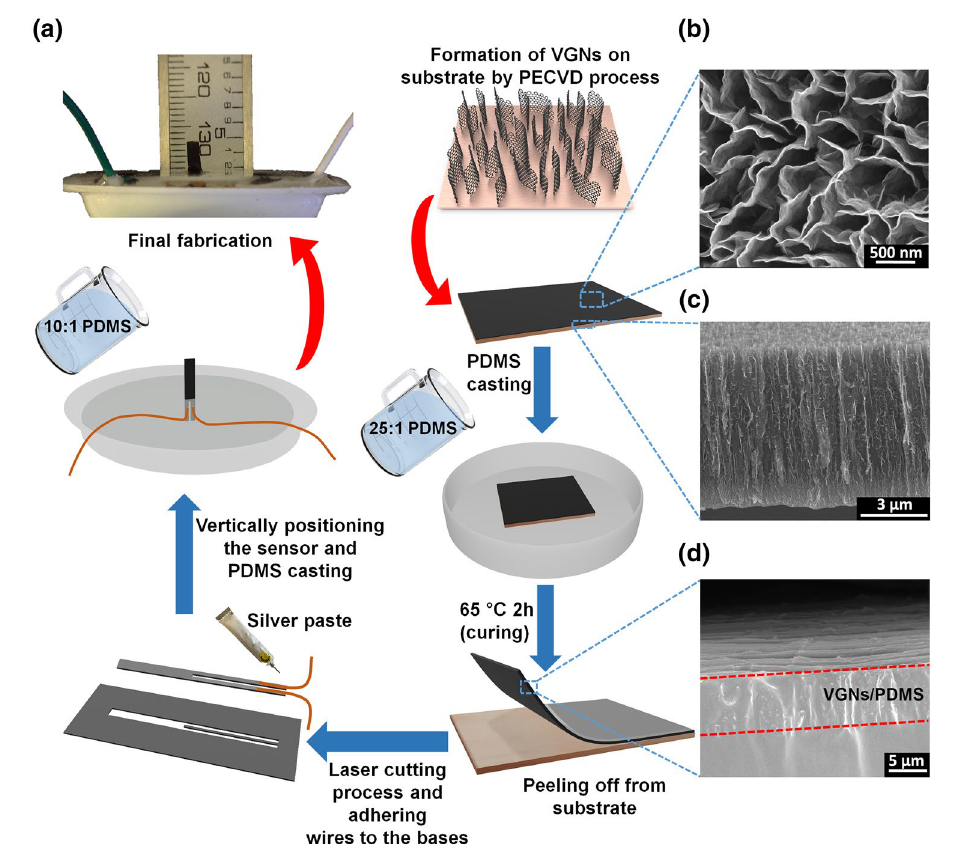
Fig. 1 a Schematic diagram of the fabrication process and SEM micrographs of VGNs and VGNs/PDMS. b Mazelike structure of vertical graphene nanosheets. c Side view of the vertically grown graphene nanosheet layer. d Side view of sensing element including vertical graphene nanosheet coated with PDMS